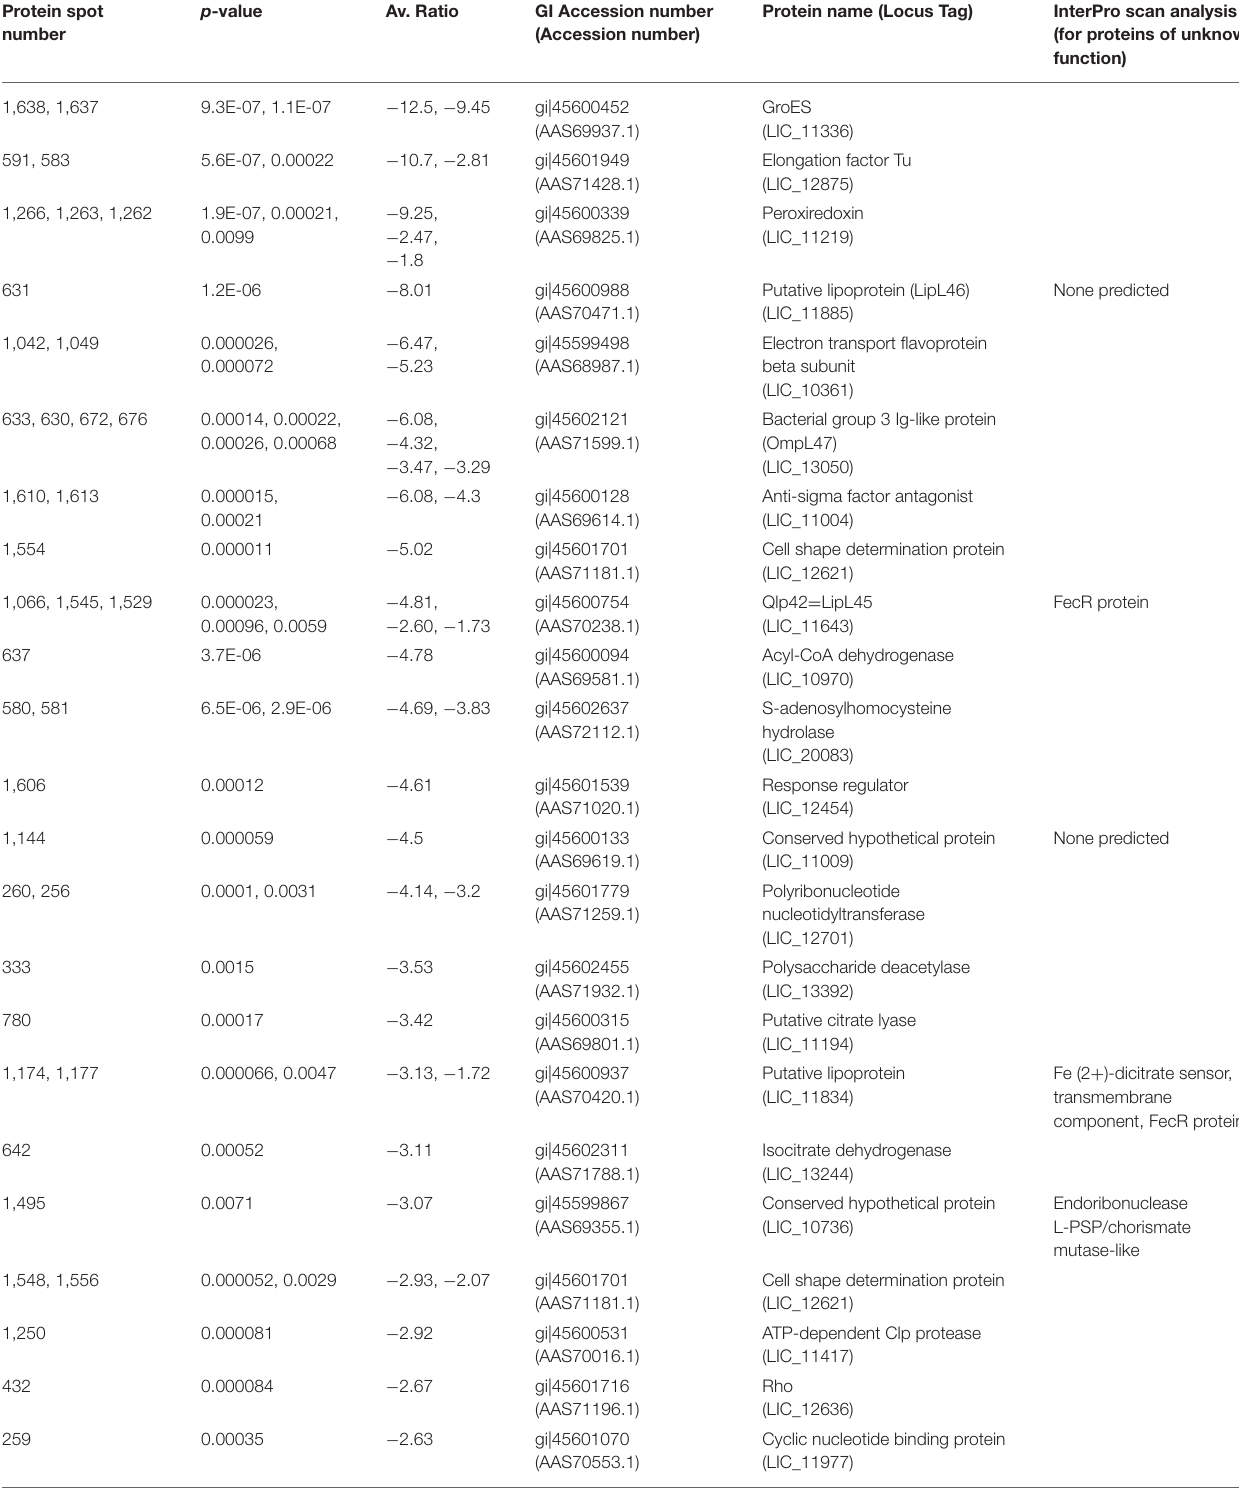
TABLE 3 | Proteins less abundant ( p < 0.05, fold > − 1.25) in DMC-cultivated leptospires compared to IV30-cultivated leptospires. Protein spot number